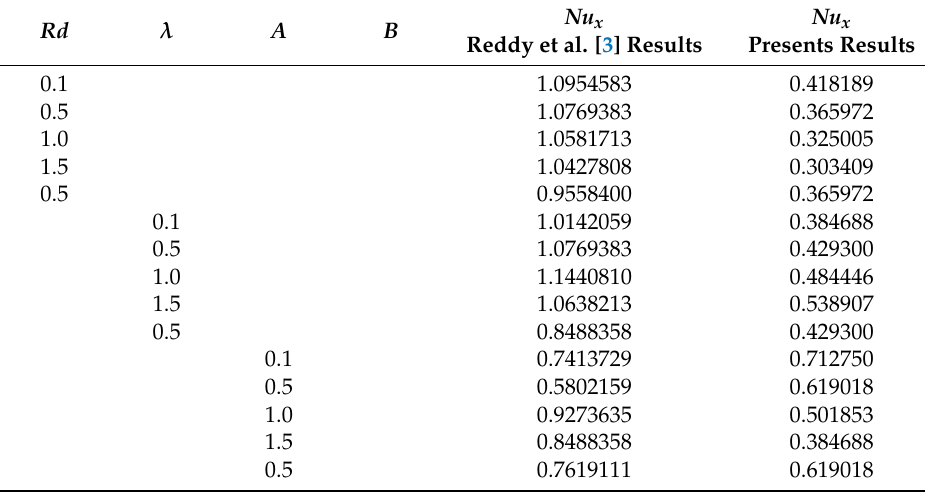
Table 2. Variation in the Nusselt number of dissimilar parameters ω = M = EI = Pr = Nt = Sc = β = 0.1.